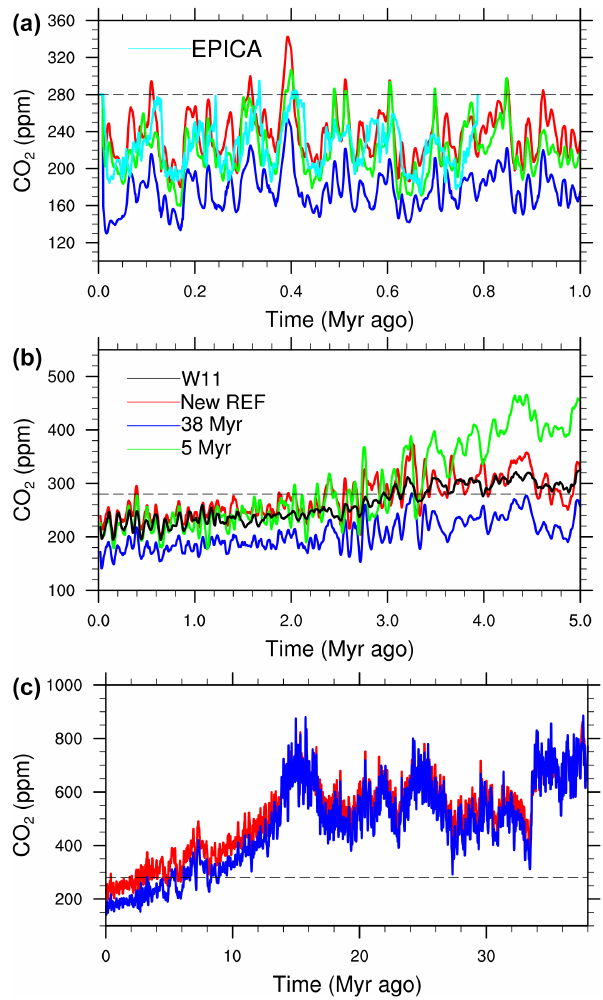
Figure 2. Atmospheric CO 2 over the past 1Myr (a) , the past 5Myr (b) , and the past 38Myr (c) . The 5Myr run from Stap et al. (2016a) (green), the extended 38Myr run from Stap et al. (2016b) (blue), the new reference run with altered cloud optical thickness (red), the hybrid proxy data–model reconstruction by Van de Wal et al. (2011) (W11; black), and the ice core record are shown (Petit et al., 1999; Siegenthaler et al., 2005; Lüthi et al., 2008) (EPICA; cyan). The ice cores stem from Antarctica, and the oldest values are from the EPICA Dome C core. Mind the differing y scales. The dashed line shows the pre-industrial value (280ppm). In panel (a) we do not show 40kyr averages, but the 1kyr output of the